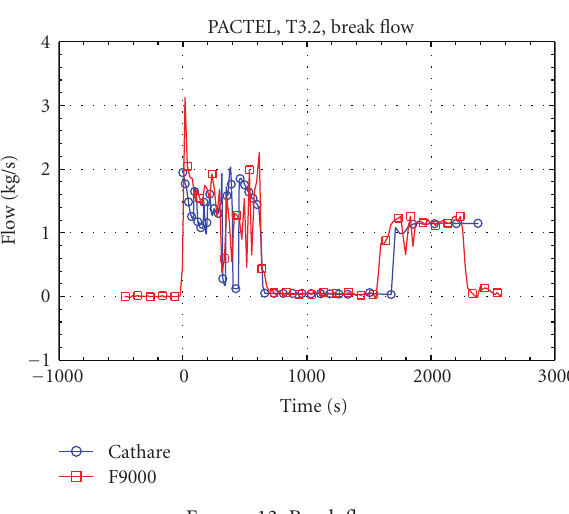
Figure 13: Break